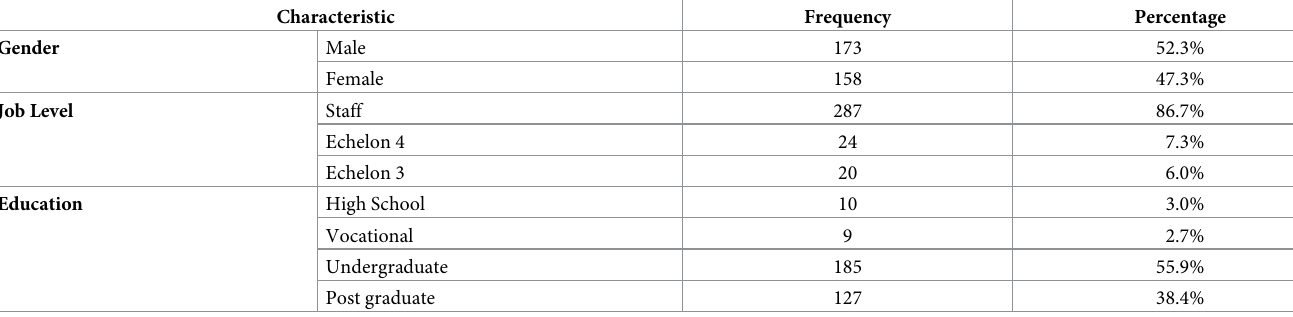
Table 1. Demographic